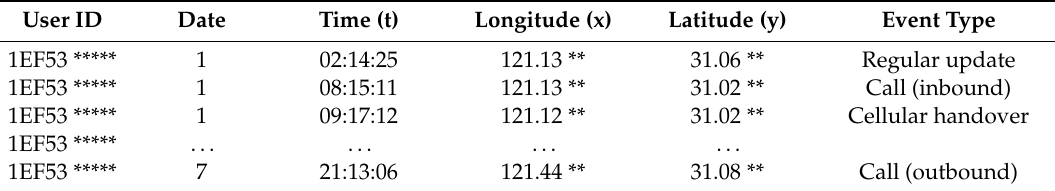
Table 1. Instance of one individual’s trajectory data.